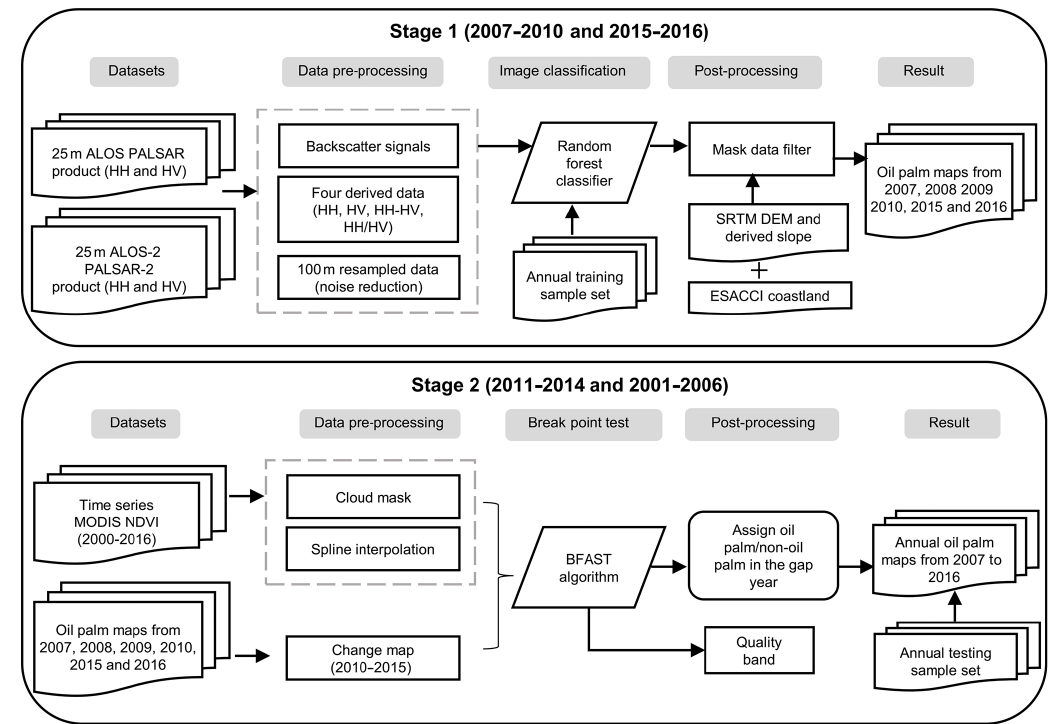
Figure 1. Workflow of the annual oil palm mapping procedure. Stage 1 stands for oil palm mapping using PALSAR and PALSAR-2 data, and Stage 2 stands for change-detection-based oil palm maps updated using MODIS